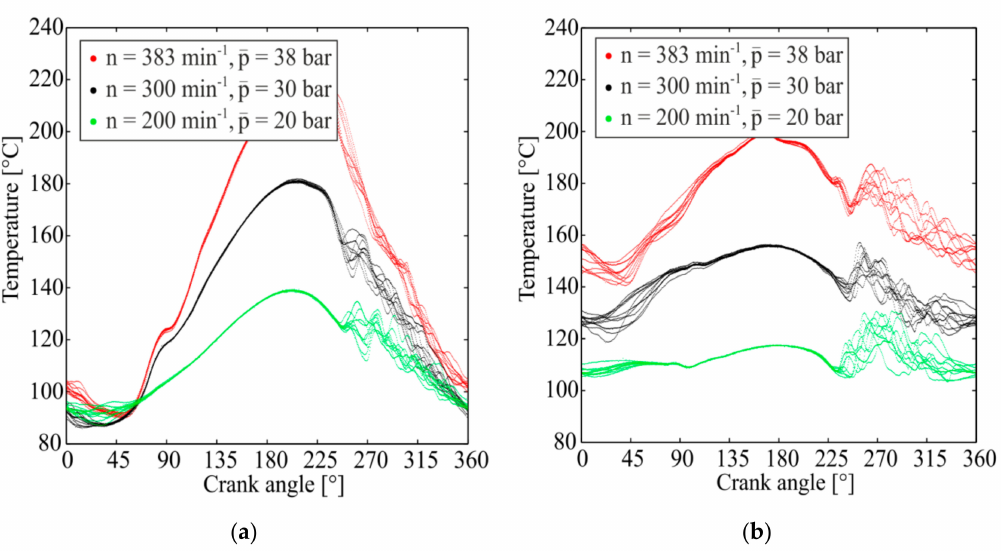
Figure 10. Measured gas temperatures in Stirling mode at di ff erent operating conditions close to the seal at y = 0.7 mm: ( a ) old seal design; ( b ) new seal